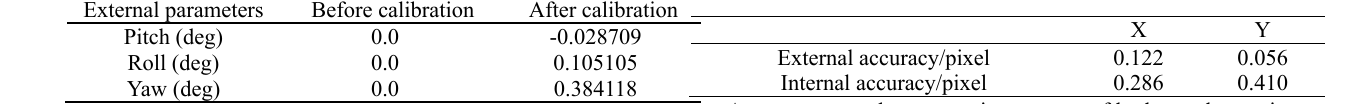
Table 4. External calibration parameters of panchromatic